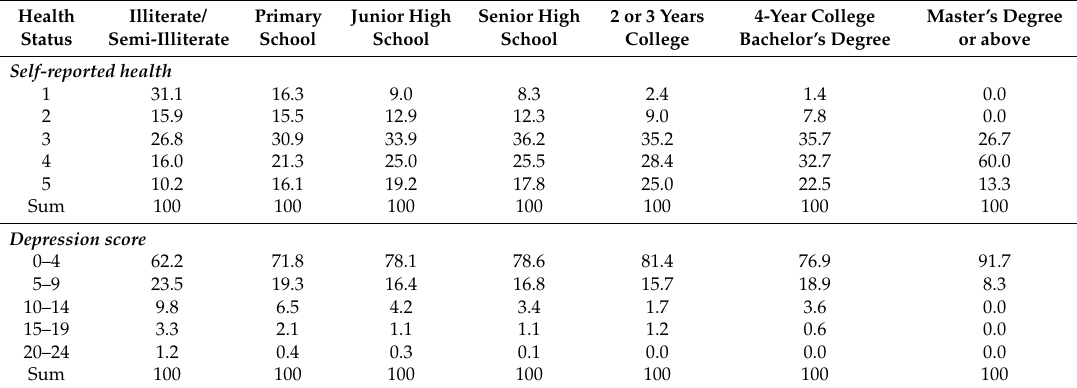
Table 2. Cross analysis of education and health,